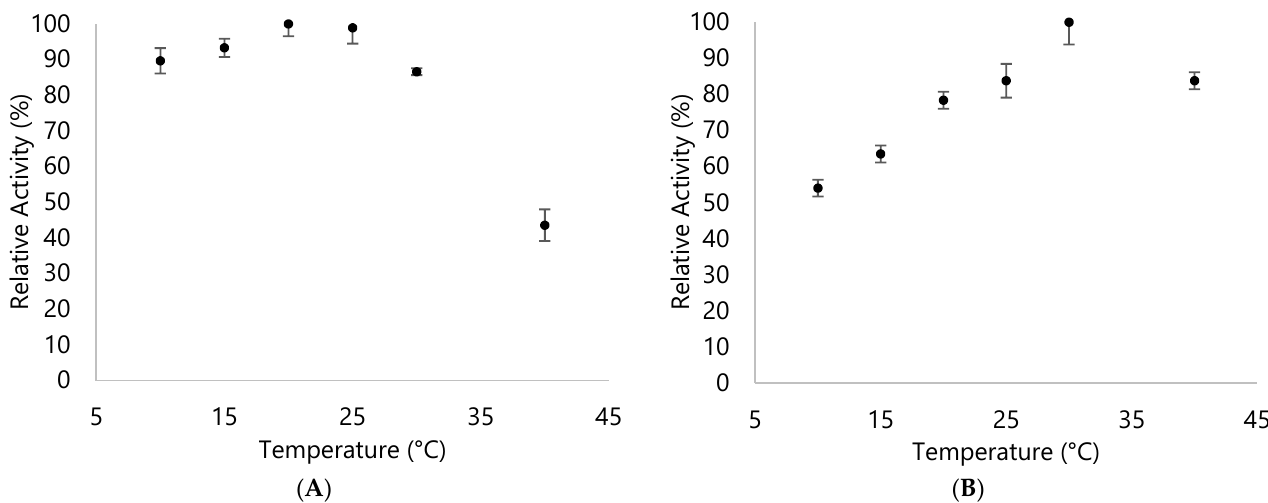
Figure 7. Relative activity of ( A ) DypA and ( B ) DypB with 144 µM RB5 assay in 25 mM citrate buffer (pH 3.6) at different temperatures.